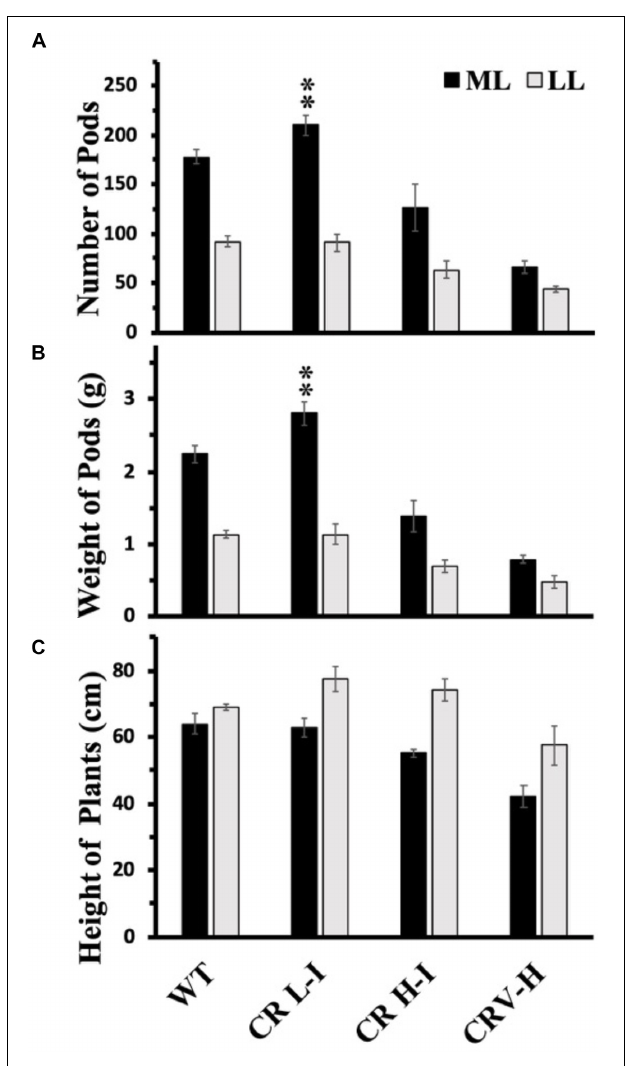
FIGURE 6 | Comparison of number of seed pods (A) , weight of seed pods (B) and height of plants (C) in wild-type and CAO RNAi transgenic lines. Wild-type (WT), CR L-I (Chl a/b = 4.5–6.5), CR H-I (Chl a/b = 6.5–8.5), and CR V-H (Chl a/b 8.5 or above) transgenic lines grown in moderate light (ML) (850 µ mol photons m − 2 s − 1 ) or in low light (LL) (200 µ mol photons m − 2 s − 1 ). Grouping of transgenic lines was made using fully expanded leaves from the top of 4–5 weeks old plants. Results represent the average and SD of three independent measurements. **, values are significantly different at P < 0.05 between experimental groups.